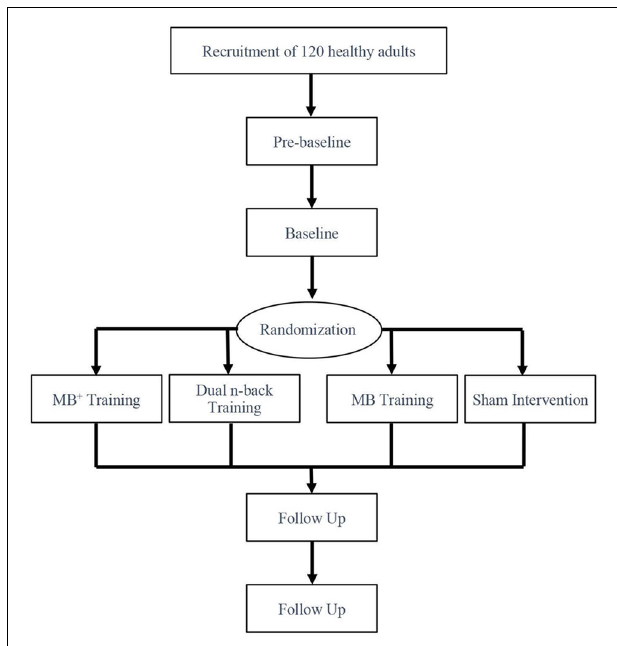
FIGURE 1 | Overview of the study